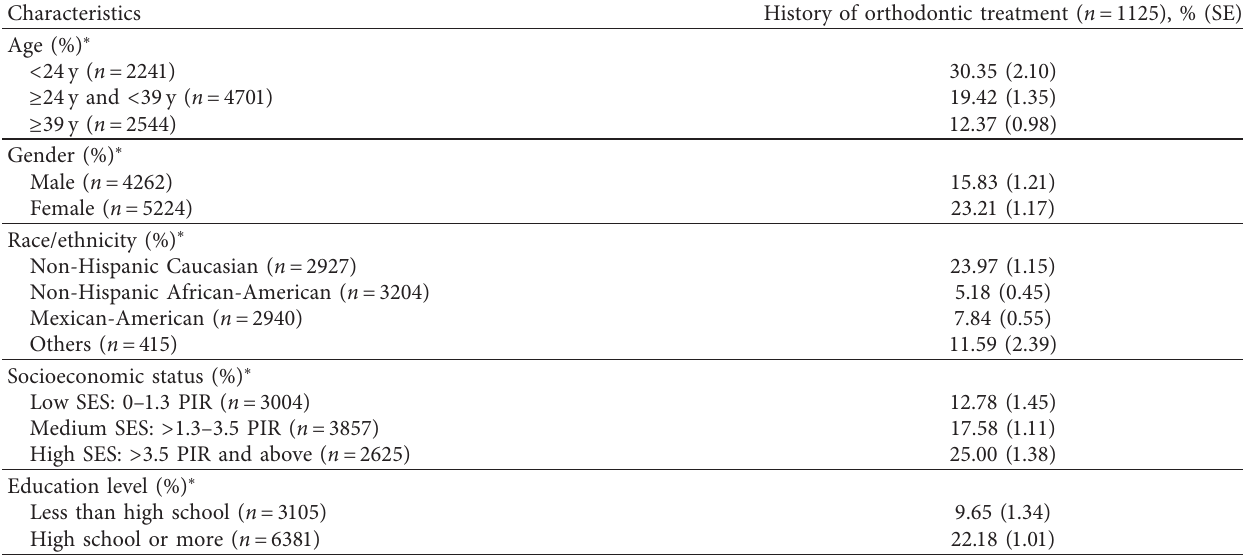
Table 2: Characteristics of the study participants who received previous orthodontic treatment ( n � 9486). Characteristics